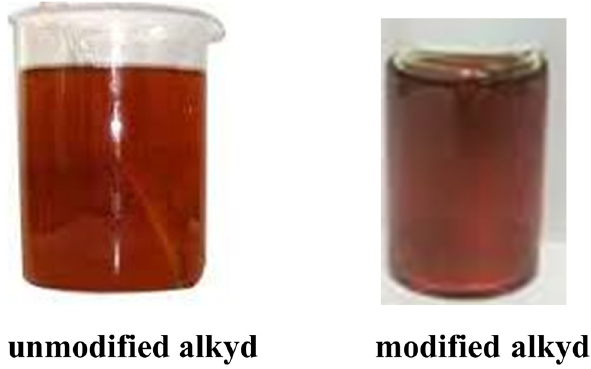
Figure 3: Color of the prepared alkyd resins.